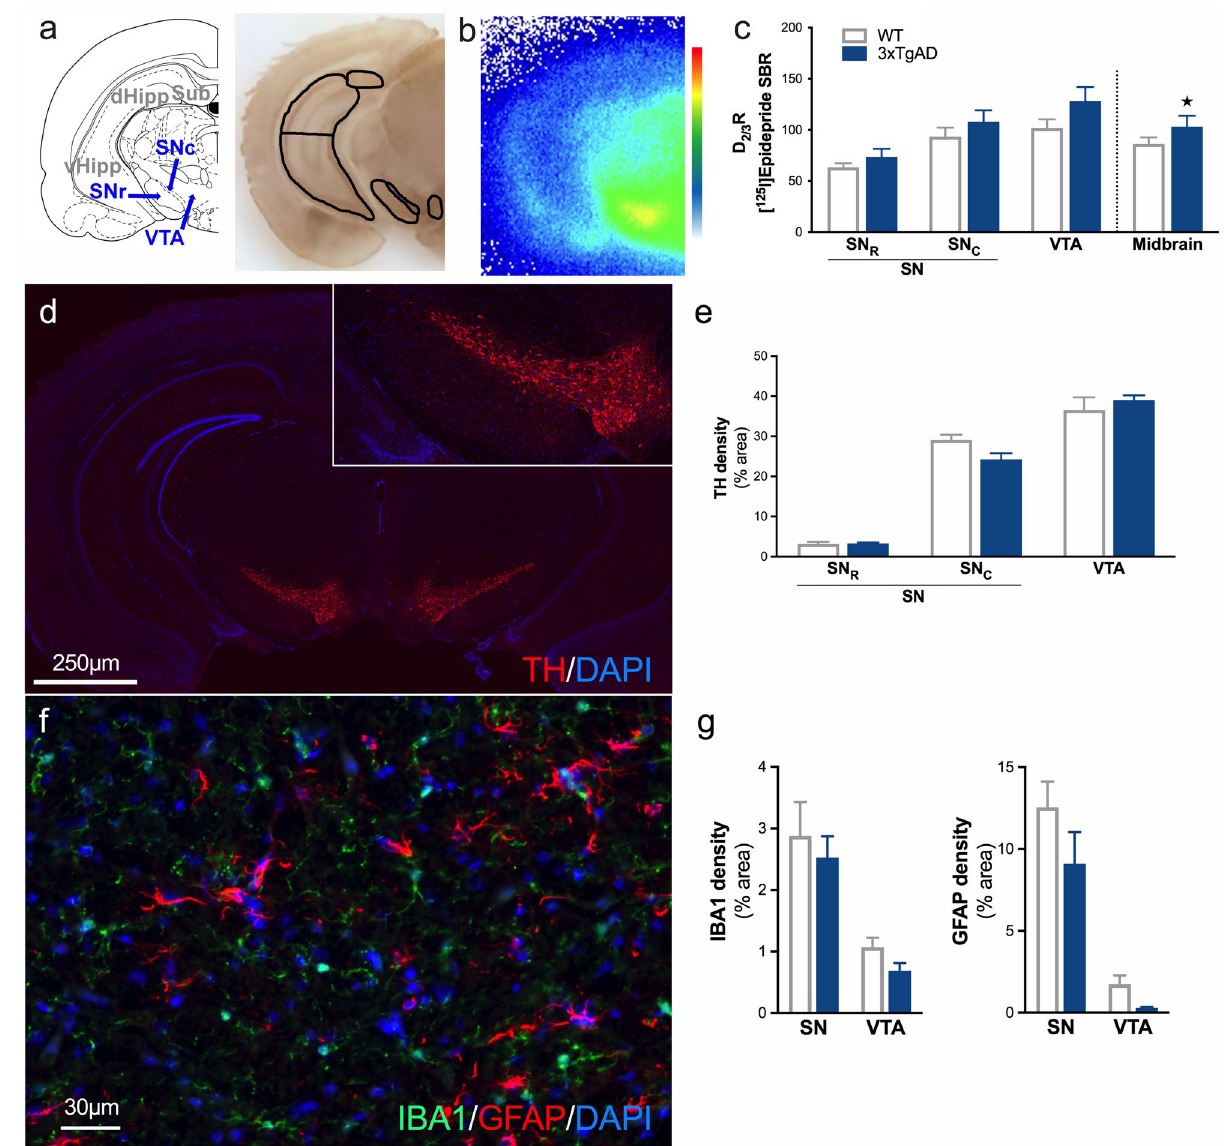
Figure 3. Increases in presynaptic D 2/3 R, without inflammation modulation, in the midbrain of 3xTg-AD mice. (a) Schematic representation of different areas of the midbrain and hippocampus which have been drawn manually according to the acetylcholinesterase staining anatomy. (b) Example of in situ labeling with [ 125 I] Epidepride. Color scale refers to activity in the autoradiograms (from 0 to 500 MBq/mg). (c) Assessment of the D 2/3 R density by [ 125 I]Epidepride specific binding ratio (SBR) quantification. (d) Example of staining at the level of the midbrain for DAPI (blue) and TH (red). (e) Quantification of the area occupied by TH staining. (f) Example of immunofluorescence for DAPI (blue), IBA1 (green) and GFAP (red) in the substantia nigra. (g) Quantification of the area occupied by IBA1 and GFAP staining. : p < ★ to remove the background (Fig. 2d, left panel). The number ramifications, number of processes and their length, calculated using concentric shell from the soma (Fig. 2d, right panel), reflect the cell complexity. As shown in Fig. 2e, the branching profile of microglia in 12-month-old 3xTg-AD is shifted to the left, demonstrating a reduction in intersection number (genotype: F 1,204 = 29.1, p < 0.001; intersection number: F 33,204 = 22.6, p < 0.001; genotype × intersection number: F 33,204 = 1.00, p > 0.05), which is typical of microglial reactive state. Increases in presynaptic D ‑autoreceptors in the midbrain of heterozygous 3xTg‑AD mice, 2/3 without modulation of inflammation markers. In the midbrain, we also observed a global upregula- tion of D 2/3 R density in 12-month-old 3xTg-AD mice compared to WT mice (Fig. 3a–c, genotype: F 1,24 = 4.83, p < 0.05; midbrain subdivision: F 2,24 = 12.52, p < 0.001; genotype × midbrain subdivision: F 2,24 = 0.38, p > 0.05). In contrast, quantification of the area occupied by TH immunostaining showed no difference between control